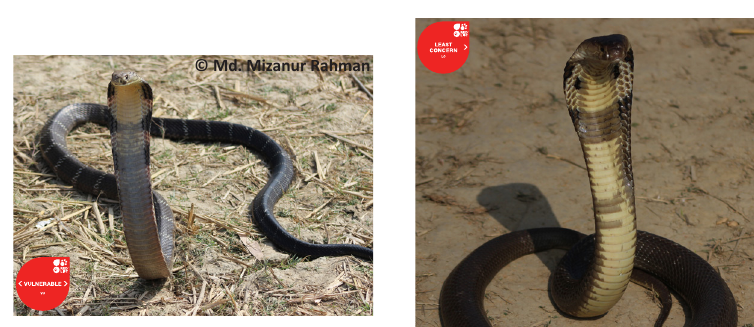
17. Ophiophagus hannah King Cobra